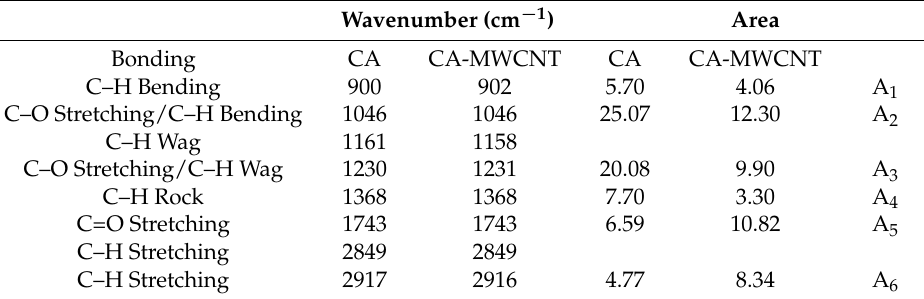
Table 6. Characteristic FTIR absorbance